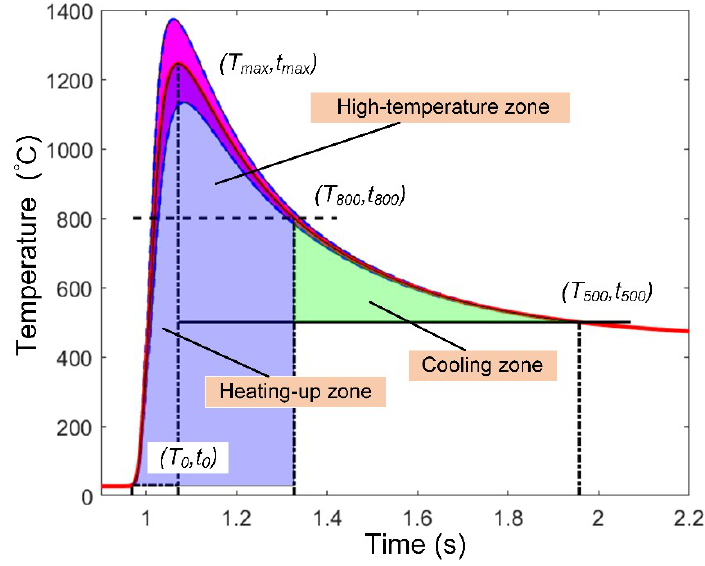
Figure 4. Thermal cycle curve and mean value curve of the laser-welding temperature field in the coarse-grained heat-affected zone.